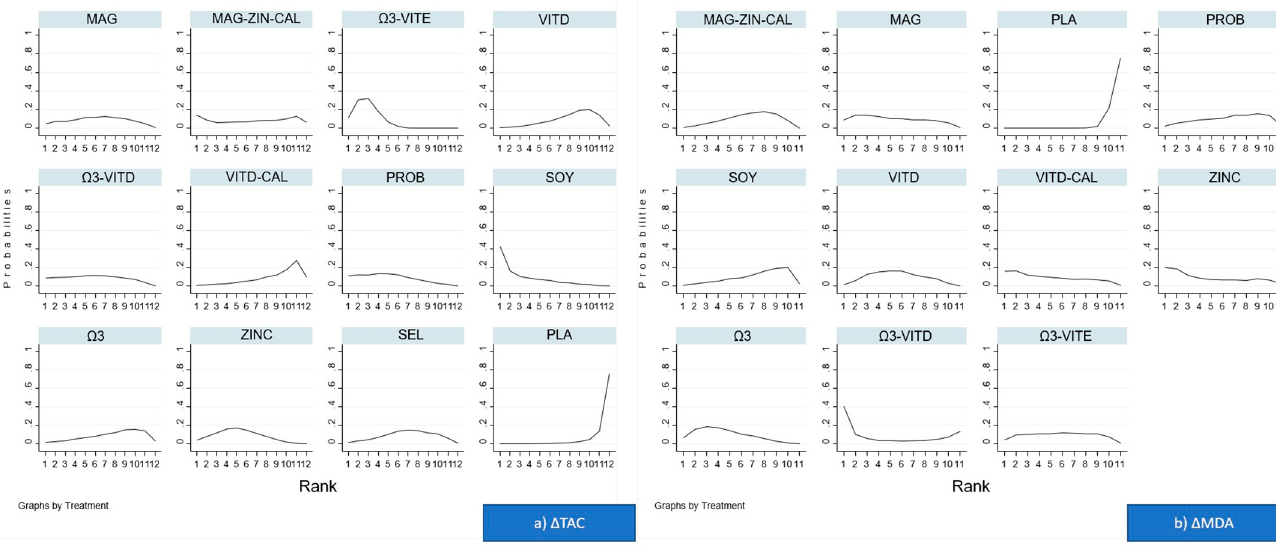
Table 5. Direct and indirect (in grey) estimates of the mean difference of TAC. Each column presents a different intervention.